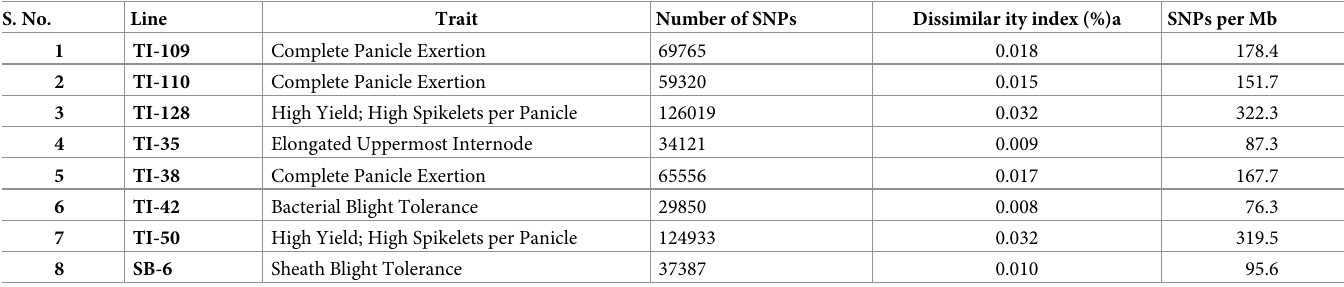
Table 4. Details of SNPs in the mutant lines with respect to wild type. S.